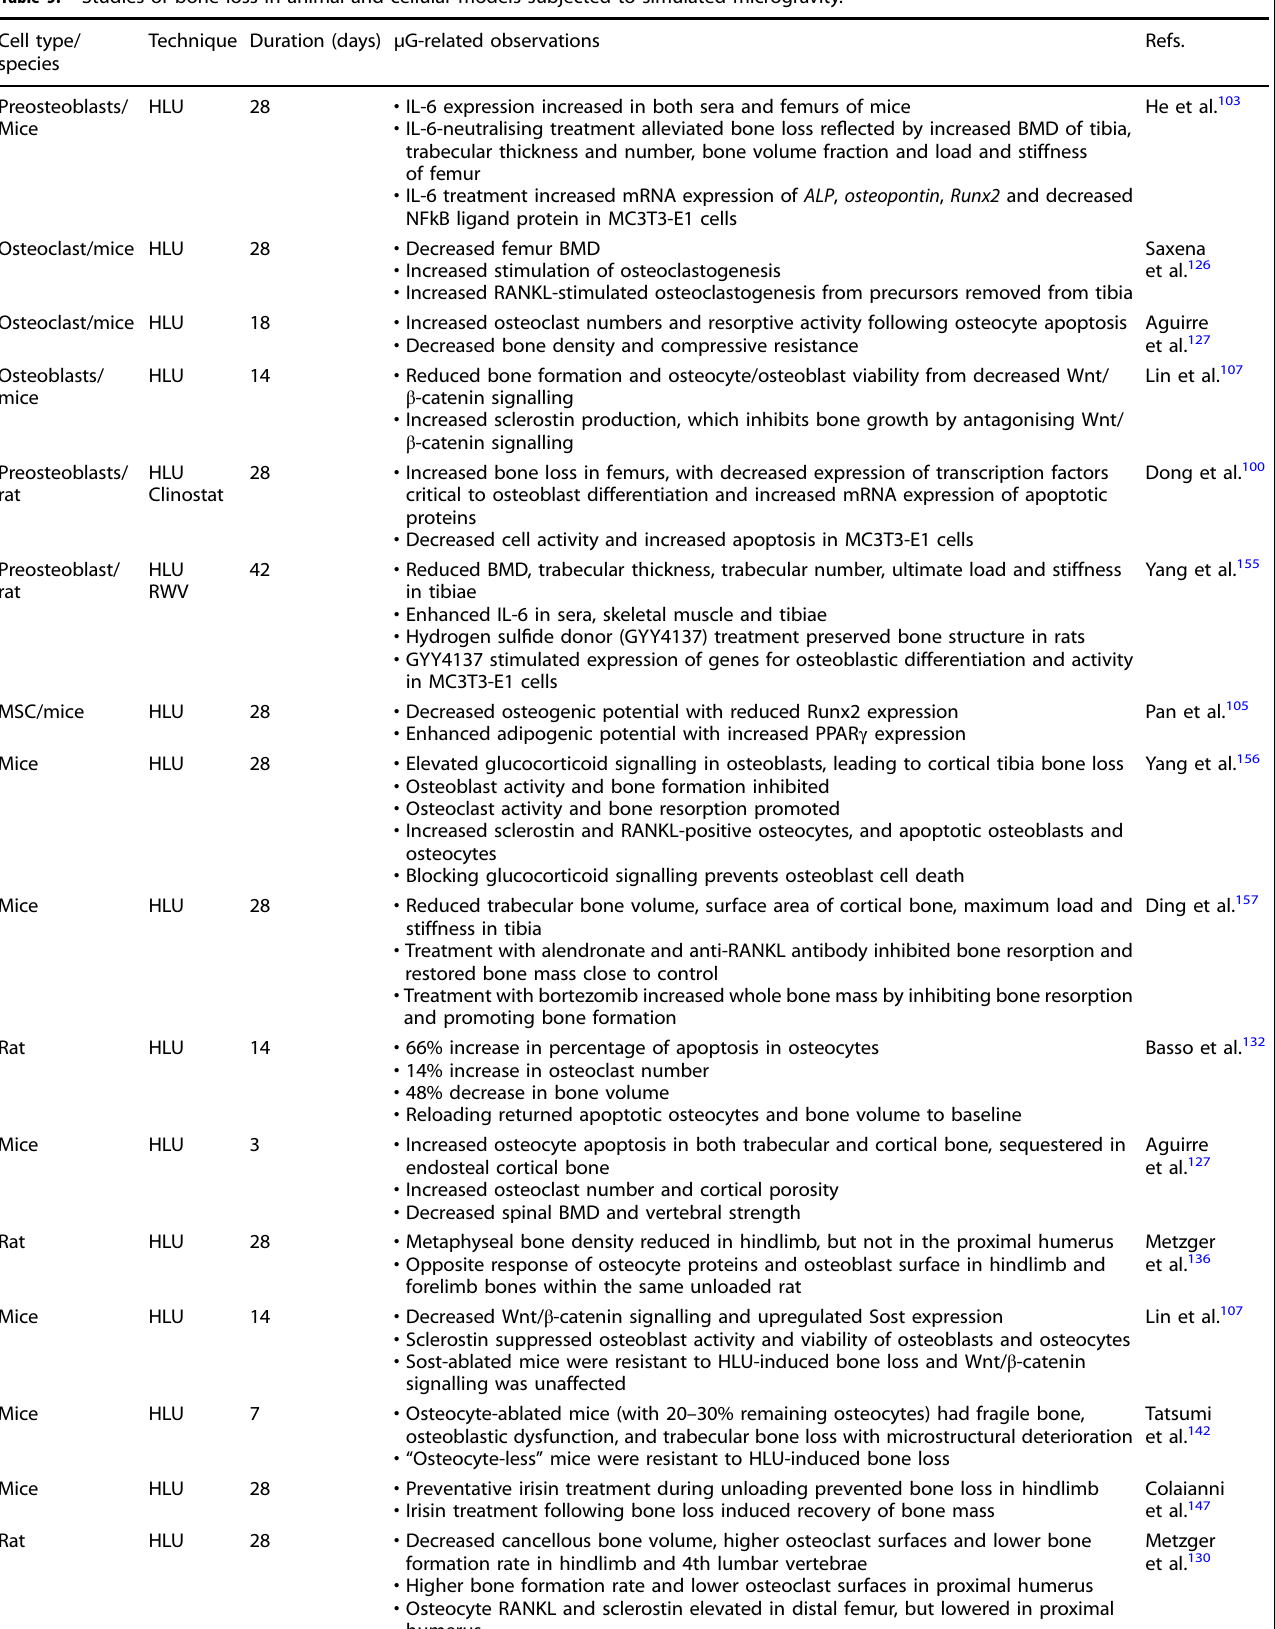
Table 5. Studies of bone loss in animal and cellular models subjected to simulated microgravity. Cell type/